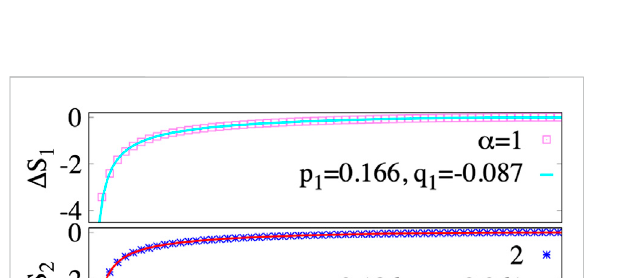
FIGURE 9 θ -Dependence of corner-edge contribution for Rényi entropy. The data are fi tted by p α lnsin θ the results are p 1 = 0.166 (±0.006), q 1 = − 0.087 (±0.001), p 2 = 0.126 (±0.001), q 2 = − 0.061 (±0.0002), p 3 = 0.113 (±0.0007), and q 3 = − 0.053